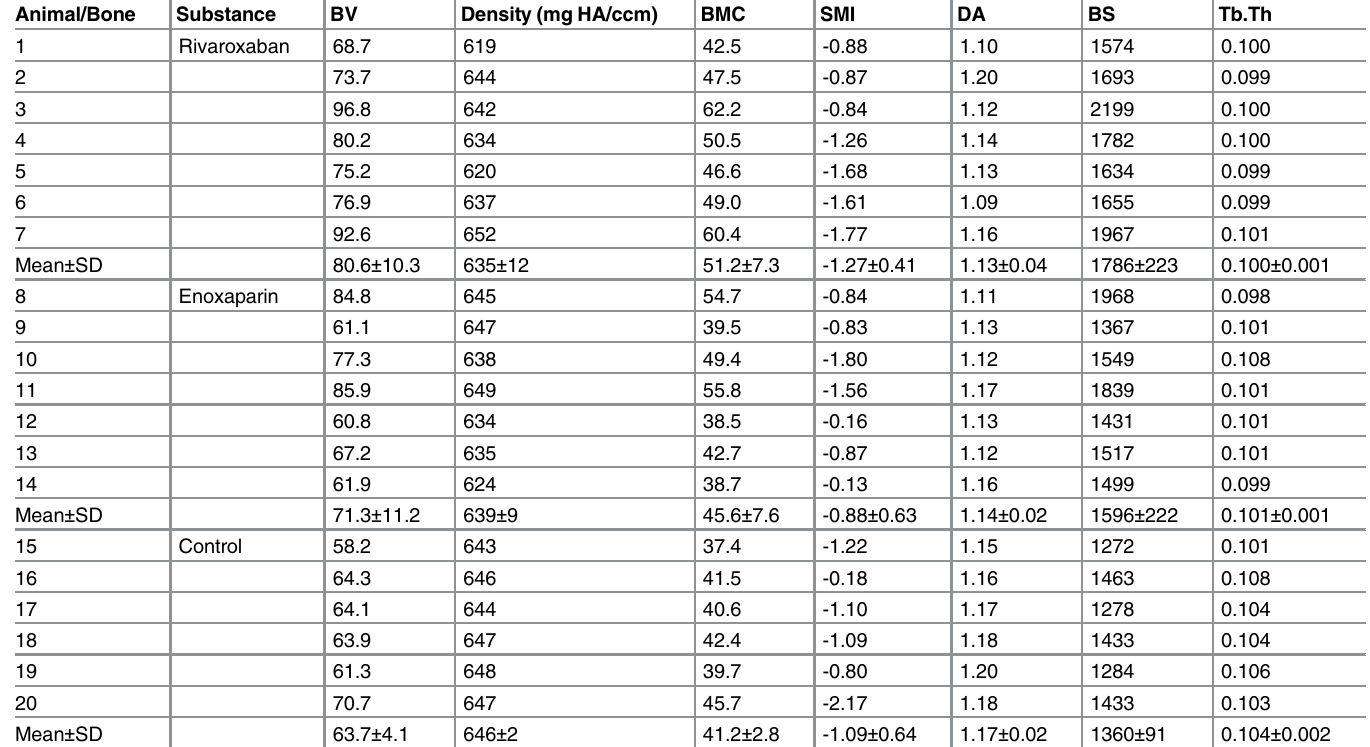
Table 2. Results Micro CT